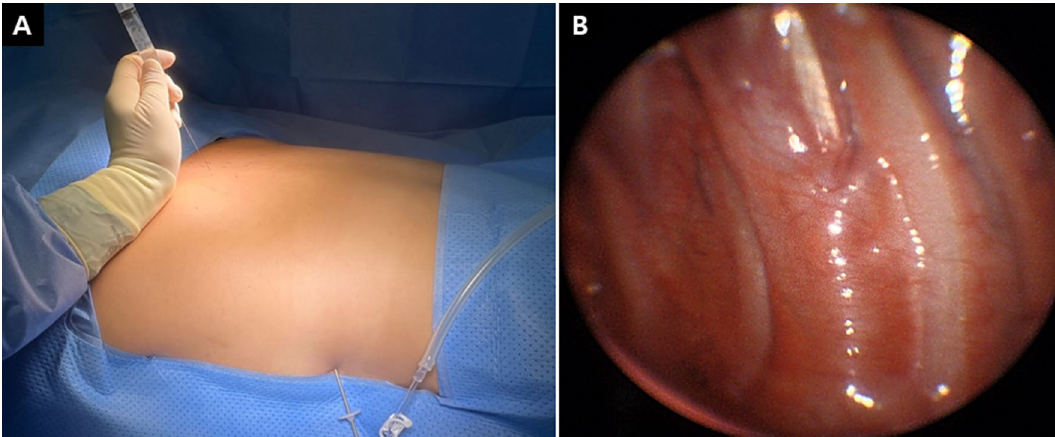
Figure 2. Use of thoracoscopy ( A ) for left thoracic sympathetic nerve block and ( B ) under local anesthesia while having the patient in the prone